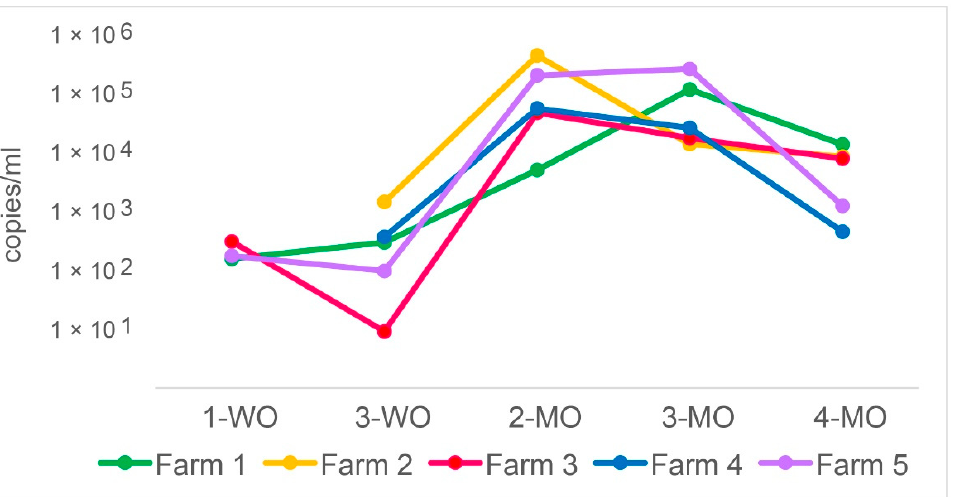
Figure 1. Dynamics of the P. suis organism loads at different life stages. The Y axis represents the P. suis organism loads expressed by sodA gene copies/mL as determined by qPCR. The X axis shows the 5 life stages from the first week (1-WO) to the fourth month (4-MO) of life. The change in the mean P. suis organism load in all samples over the 4-month obser-